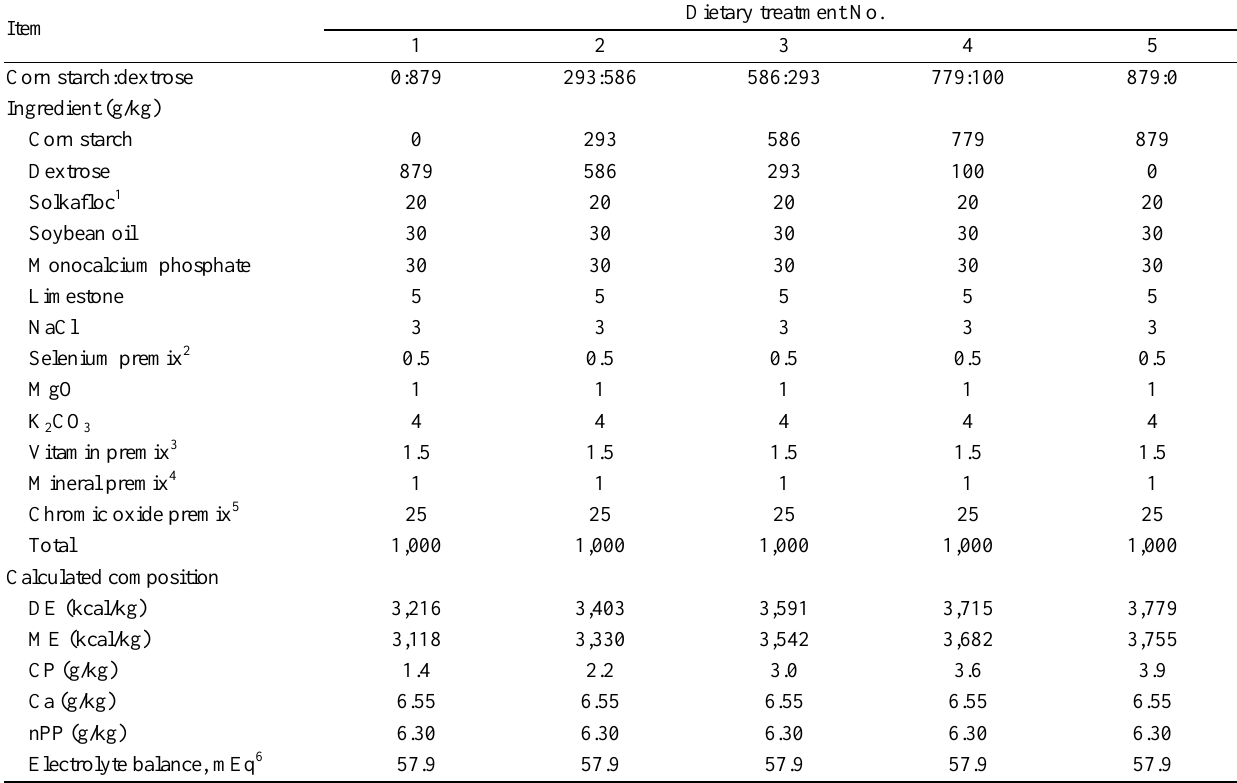
Dietary treatment